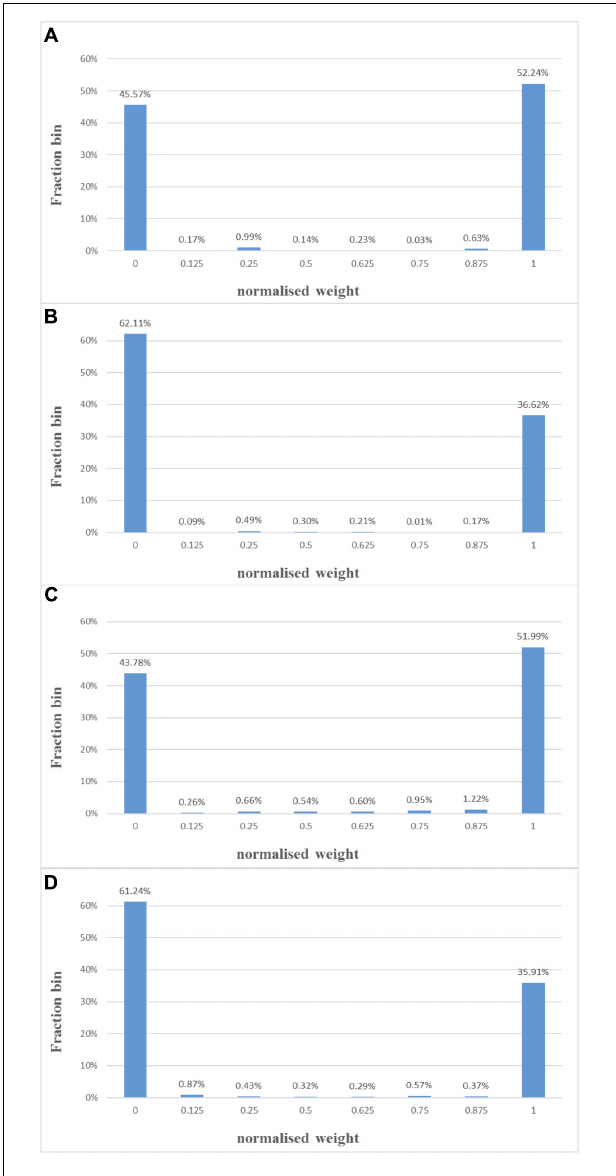
FIGURE 12 | Balanced excitation experiment. (A) Mean weight distribution after 1 s of STDP with the standard exponential equations for a pre- and post-synaptic train with a rate of 10 and 10 Hz. The bimodal distribution of strong and weak weights is apparent; (B) same as (A) , but with a rate of 10 and 20 Hz. Now more weights are weak than strong ; (C,D) same as (A,B) , but with a fixed adaptation step (set to 1